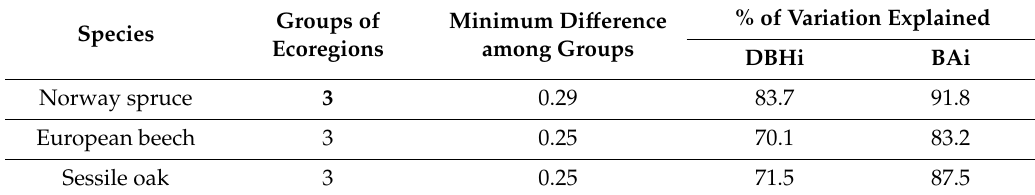
Figure 6. Identification of the number of groups of ecoregions using Ward’s Minimum Variance and Cubic Clustering Criterion for Norway spruce ( a ), European beech ( b ) and Sessile oak ( c ). Because similar results were obtained for DBHi or BAi, we have represented only the results for DBHi. Table 7. Grouping of ecoregions with similar growth according to the hierarchical cluster analysis.